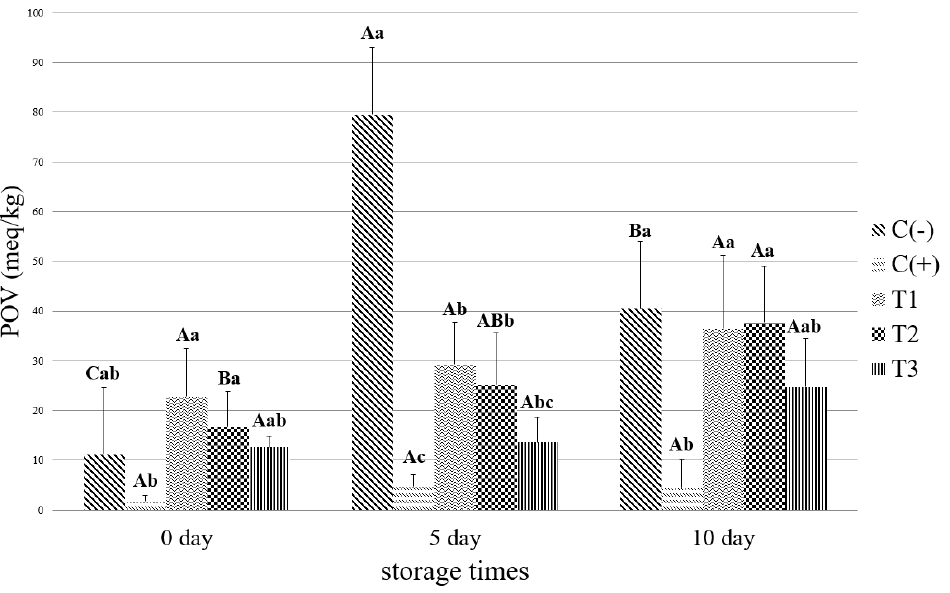
Figure 2. Peroxide value (POV) of patties with different levels of soy sauce during 10 days of storage. A–C Least square means with different letters within the same day of storage time are significantly different ( p < 0.05). a–c Least square means with different letters within the same treatments are significantly different ( p < 0.05).